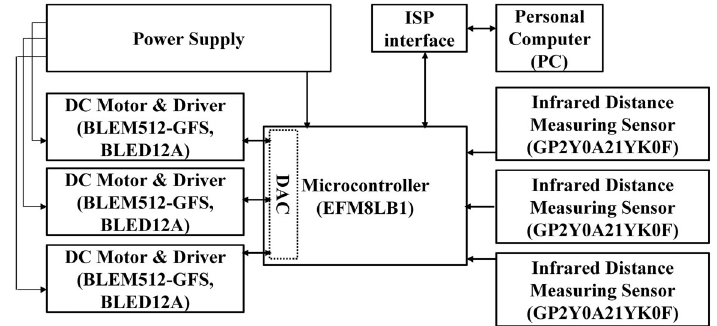
Figure 3. Block diagram of the hardware circuit.